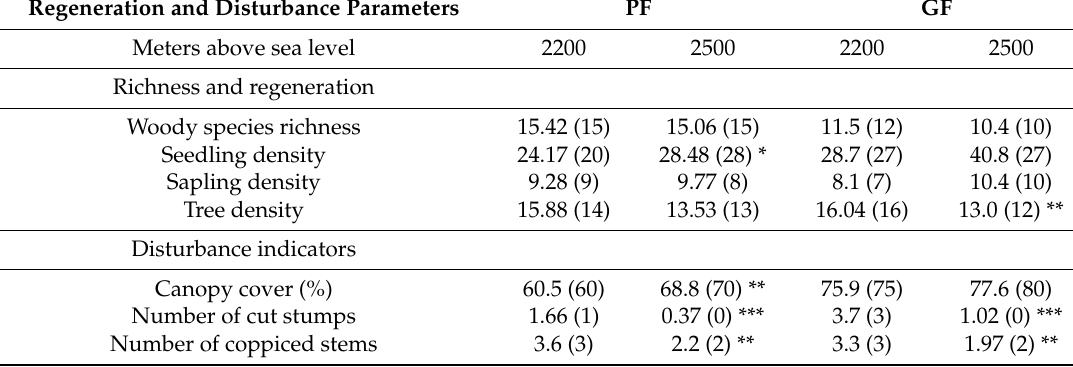
Table 4. Comparison of means (median) of regeneration and disturbance parameters between two sampled elevations in protected forests (PF) and in government forests (GF) in the Langtang area of Nepal, tested by a Mann-Whitney U -test.